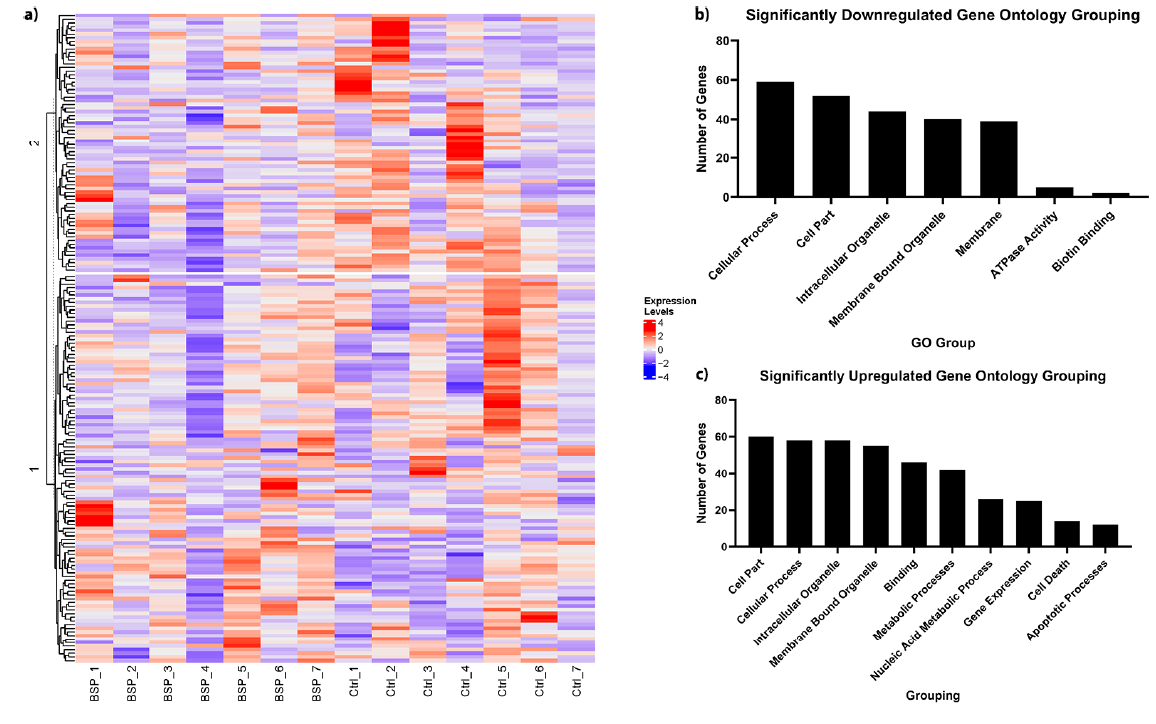
Figure 5. RNA sequencing heatmap ( a ), downregulated gene ontology ( b ), and upregulated gene ontology ( c ) analyses for breast tumor samples of peripubertal BSp-treated HER2/neu mice. For RNA-sequencing ( a ), n = 7 and genes were deemed significant if their adjusted p -value was p < 0.05. RNA sequencing results informed GO analyses in b and c. For GO analyses, a cutoff of adjusted p < 0.05 was used to determine significant enrichment. The histograms shown here represent the GO groupings with the top 5 highest gene counts, as well as other groupings with physiological relevance to cancer biology.